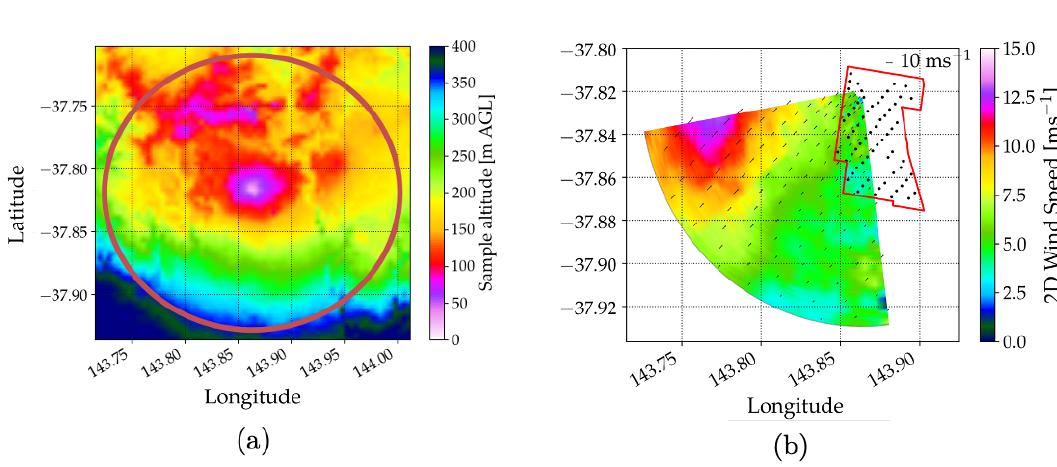
Figure 4. ( a ) LiDAR sampling altitude relative to the ground (the map accounts for topography and altitude changes resulting from non-horizontal scanning). ( b ) Reconstructed wind field on 1 November 2019 at 22:38:40 (UTC+10). The red circle in ( a ) represents the maximum range gate of the LiDAR. The black dots in ( b ) show the 64 turbine locations, and the red lines delineate the wind farm